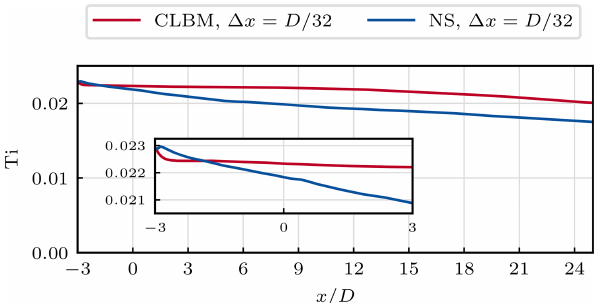
Figure 12. Stream-wise evolution of the turbulence intensity Ti without ALM. Each data point Ti( x ) refers to the spatial mean of 64 points in the cross-stream direction z with − D ≤ z ≤ D .